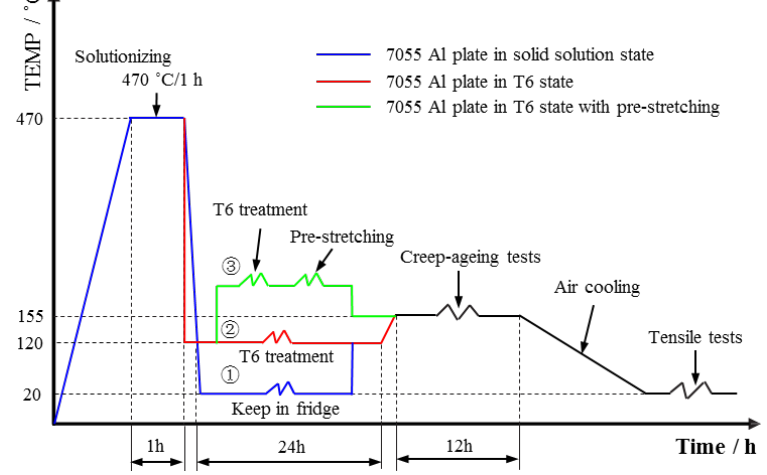
Figure 2. Material preparation, scheme chosen, and overall test programme presenting corresponding optimal scheme.